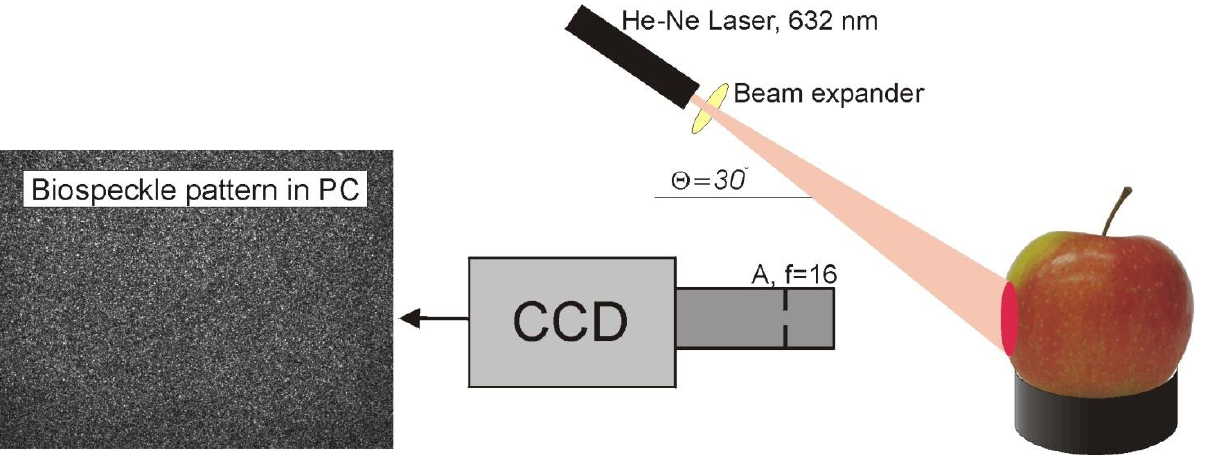
1. Scheme of experimental setup for biospeckle activity measurement. A—aperture, f—value of objective aperture, CCD—charge-coupled device, θ—angle between laser and CCD. Biospeckle pattern is changing in time for biological objects (see AVI supplementary